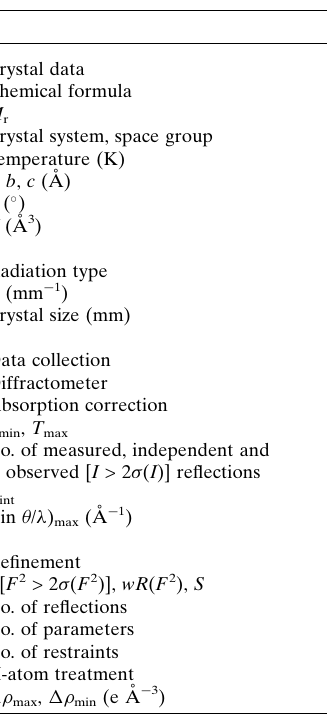
Table 3 Experimental details.